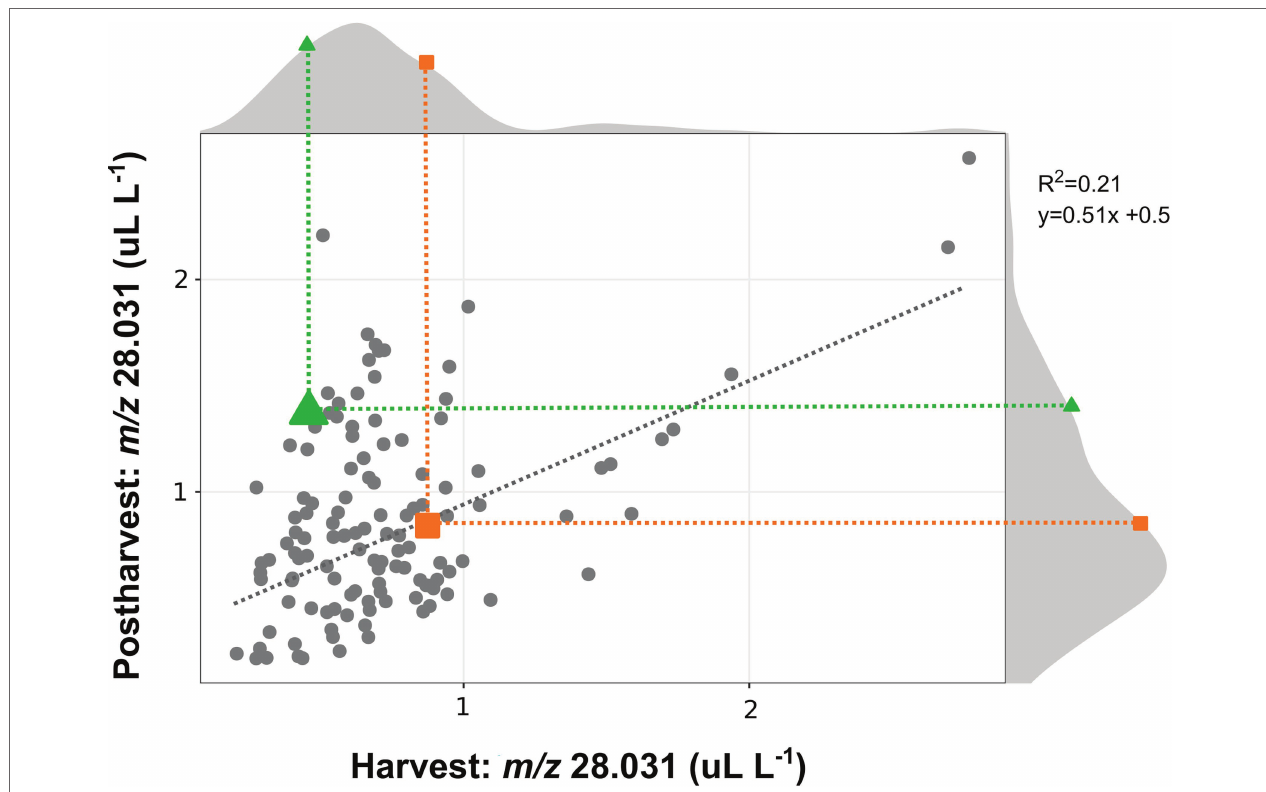
FIGURE 3 | Correlation plot and density plot of the ethylene content determined at harvest and after 4 weeks of storage of 124 accessions of a bi-parental full-sib population obtained by the crossing between the cultivars “Biloxi” (green triangle) and “Draper” (orange square). Each measurement was done in three replicates. Ethylene measurement was assessed on frozen powdered material by using an PTR/SRI-ToF-MS in H 3 O + mode. Ethylene content was estimated taking into account the concentration of the mass m/z